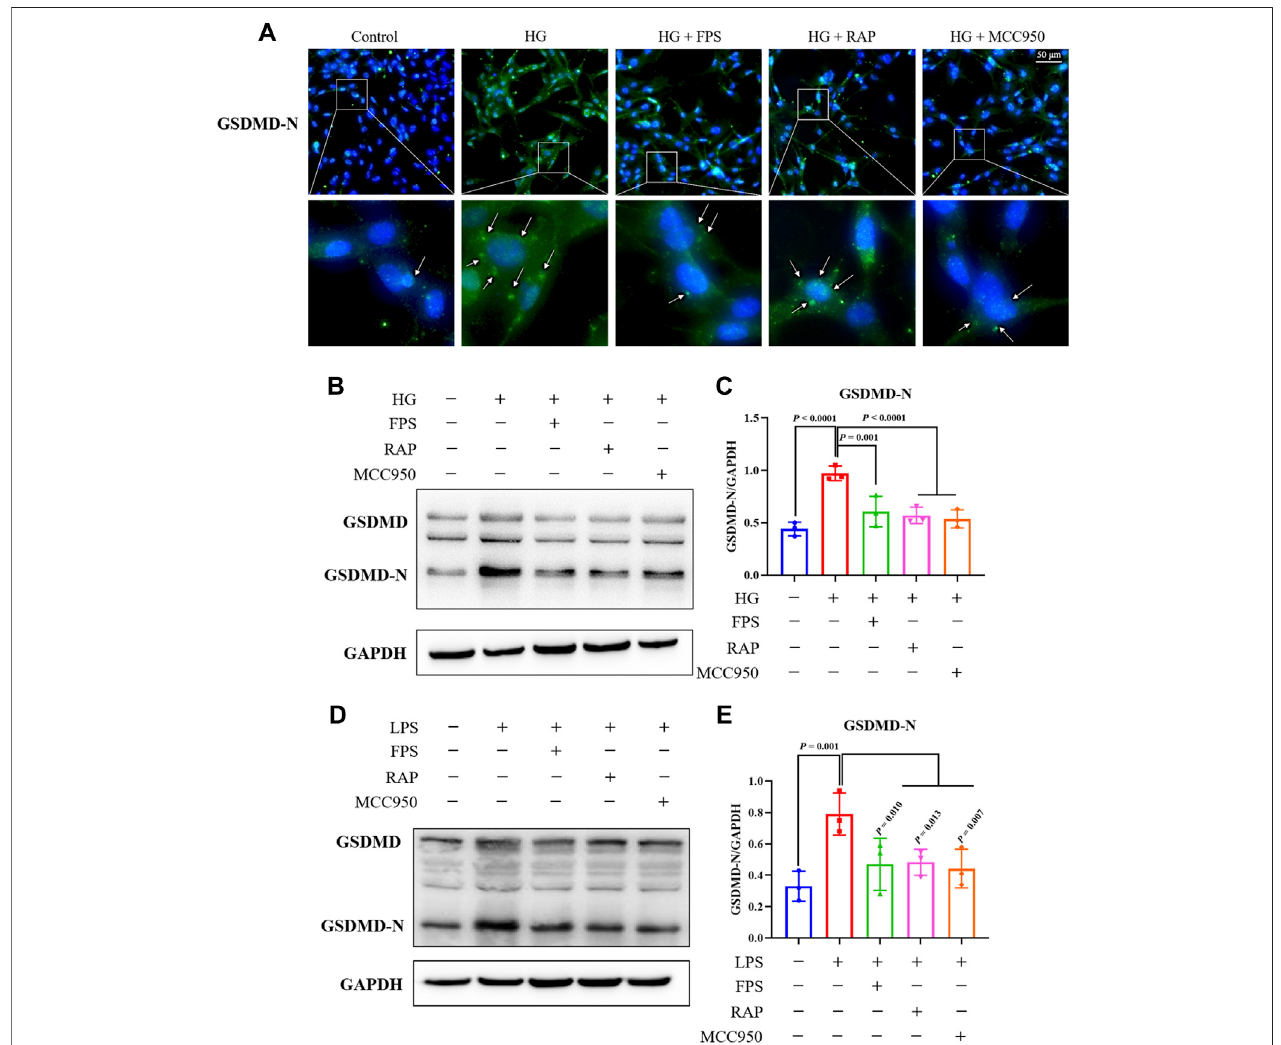
FIGURE8| EffectsofFPSandRAPonpodocytepyroptosis invitro . (A) Immuno fl uorescentlabelingwithGSDMD-N.NucleicounterstainedwithDAPI.Inthelocally enlarged lower panel, the arrow shows that GSDMD-N relocated to the cell membrane (×400). Scale bar = 50 μ m. (B) The WB analysis of GSDMD and GSDMD-N in MPC-5 cells exposed to HG with or without FPS or RAP for 24 h; (C) The rate of GSDMD-N to GSDMD. (D) The WB analysis of GSDMD and GSDMD-N in MPC-5 cells exposed to LPS with or without FPS or RAP or MCC950 for 24 h; (E) The rate of GSDMD-N to GSDMD. The data are expressed as the mean ± SD.